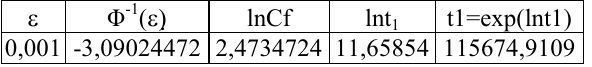
Fig 10 . Failure probability for the non-corroded speciemn with specified life = 450000 cycles